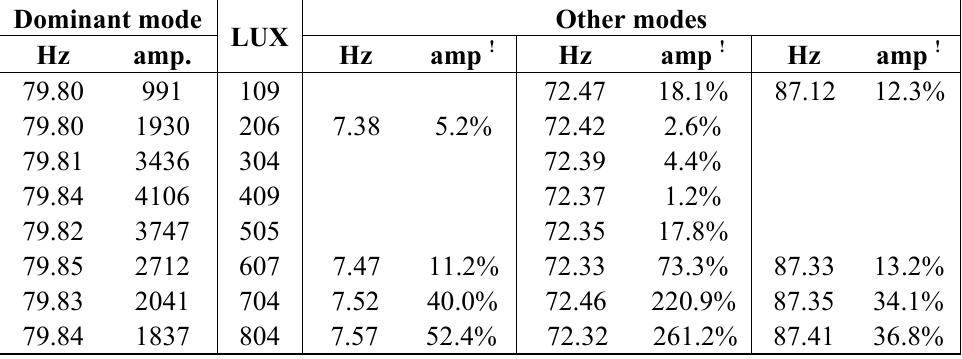
Table 6. Frequency response of the high speed camera using different illumination of light source.